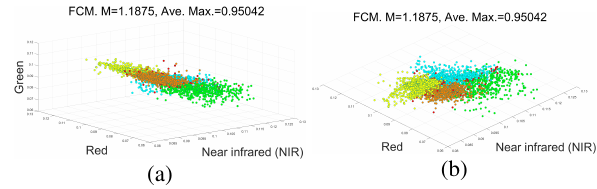
Figure 7. Buildings-streets superpixels after classification.